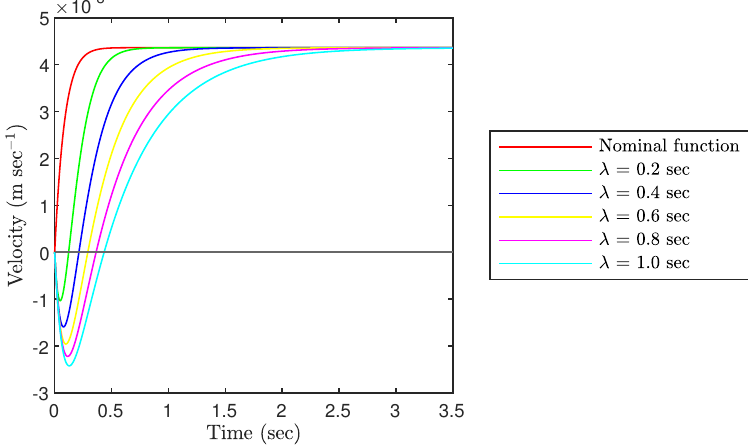
Figure 8. Analysis on the behavior of 1st order Padé approximation for G ol , u , τ